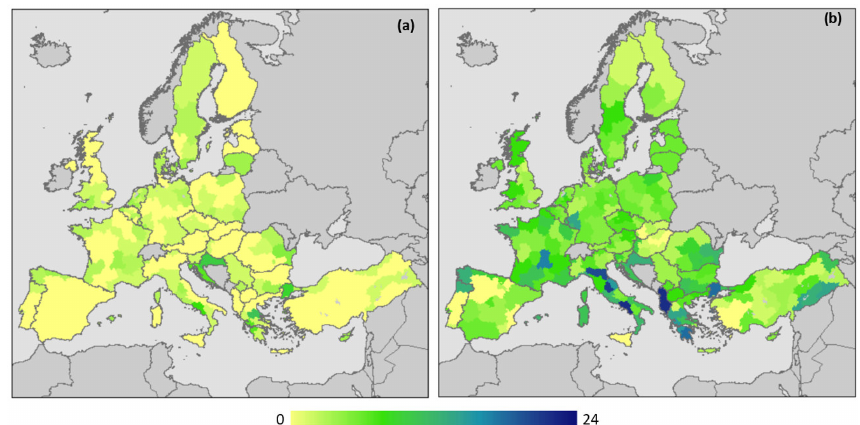
Figure 5. Spatial distribution of the length (in dekads) of the longest period with F p − = 1 ( panel a) and F − = 1 ( panel b) .